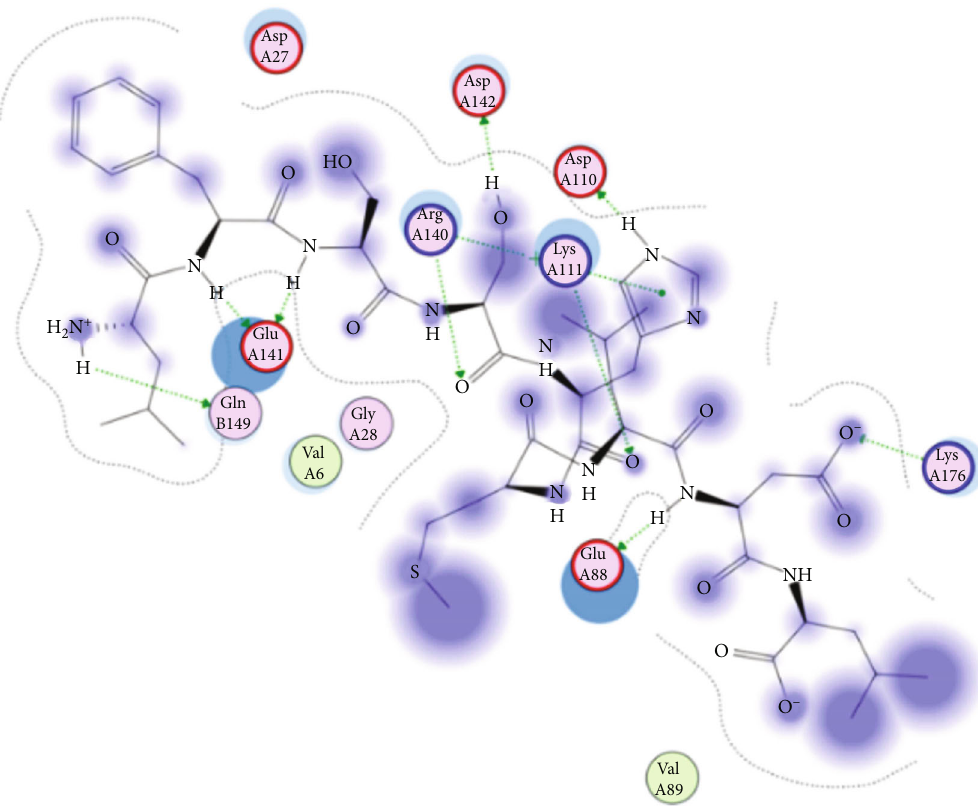
Figure 22: Illustration of the 3D interaction of the best docking poses of LFSSHMLDL in the binding sites of HLA-DRB1 ∗ 01:01.